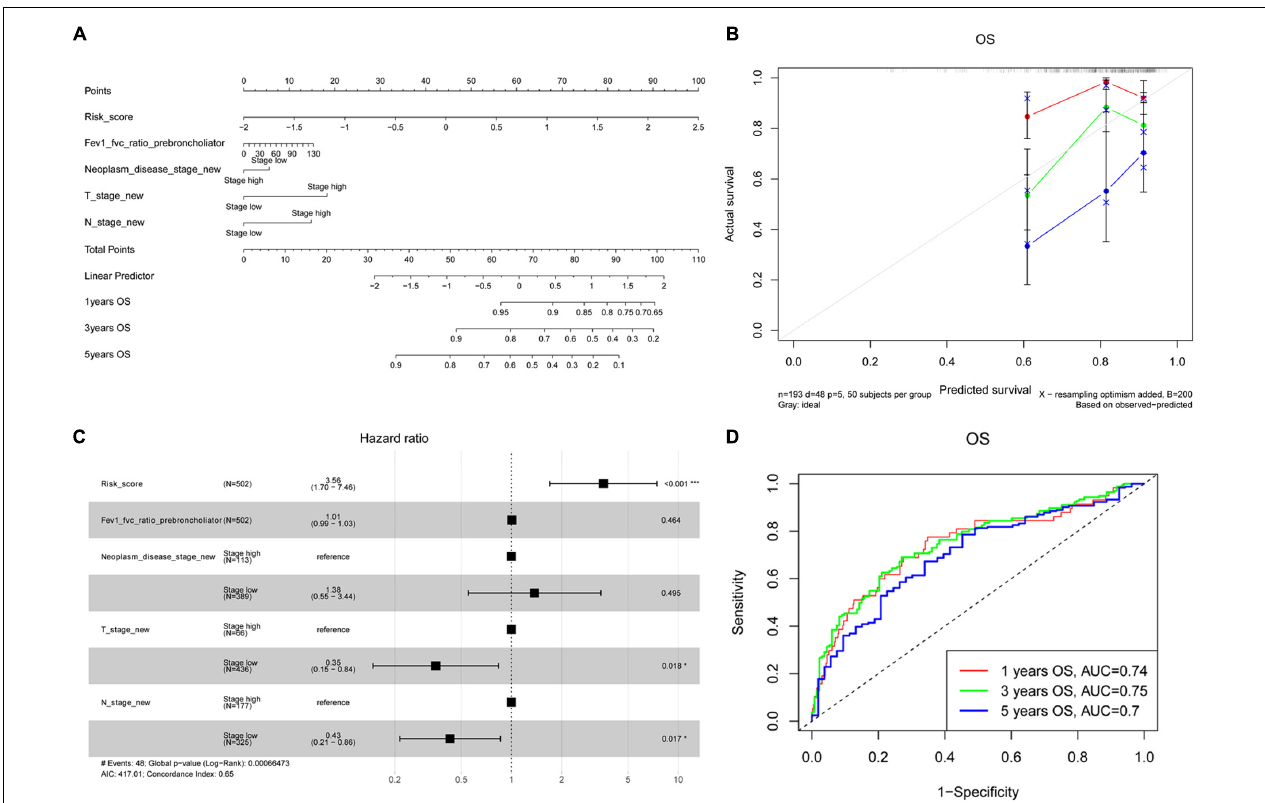
FIGURE 4 | Development of prognostic NMGs nomogram for LUAD patients. (A) The nomogram for predicting 1-, 3-, and 5-year OS probabilities of LUAD patients. (B) Calibration plot of the established nomogram for predicting probabilities of 1-, 3-, and 5-year OS. (C) Multivariate Cox regression analysis of risk factors (including risk score, Fev1 Fvc ratio of prebroncholiator, neoplasm disease stage, T stage, and N stage). (D) The ROC curves of the nomogram for predicting 1-, 3-, and 5-year OS. OS, overall survival; ROC, receiver operating characteristic; T stage, tumor stage; N stage, lymph node